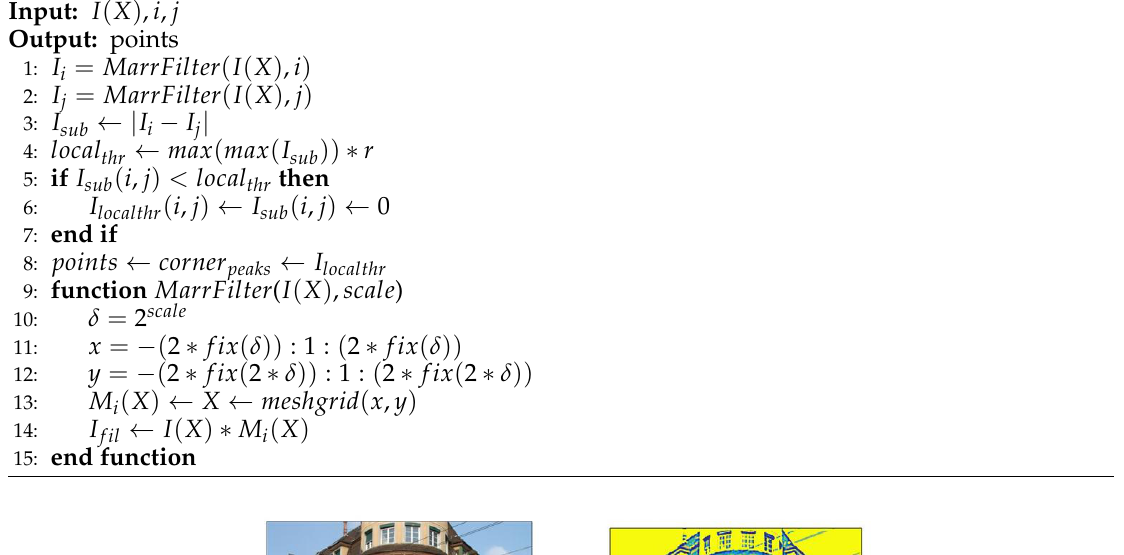
Algorithm 1 Marr wavelets within scale-interaction algorithm